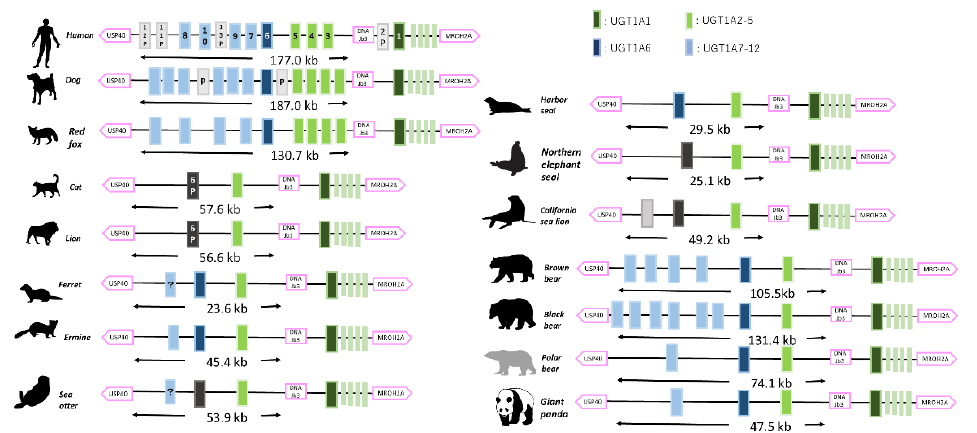
Figure 2. Synteny analysis of UGT1As in Carnivora. Synteny of UGT1A coding loci among Carnivora is shown. Representative species for each family were selected. UGT1As are known to share common exons (2 – 5) among isoforms and are shown as pale green blocks. UGT1A1 is dark green, UGT1A2 – 5 is bright green, UGT1A6 is dark blue, and UGT1A7 – 12 is pale blue. Pseudogenes are shown as black or gray blocks. Lengths of coding loci from DNAJB3 to MROH2A are also shown as indicator for genetic loss in these loci. Manually curated unannotated isoforms are shown with “?”.